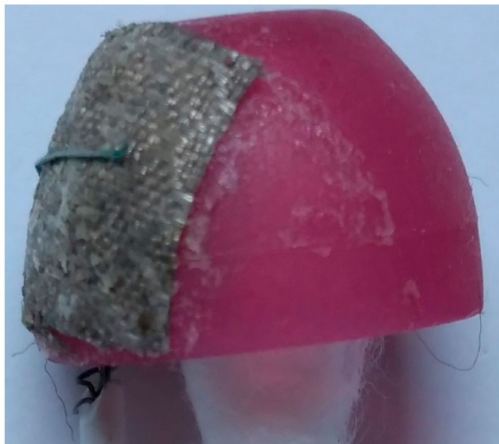
Figure 4. Single channel electrode used in the experiment using earphone rubber and silver-adhesive fabric